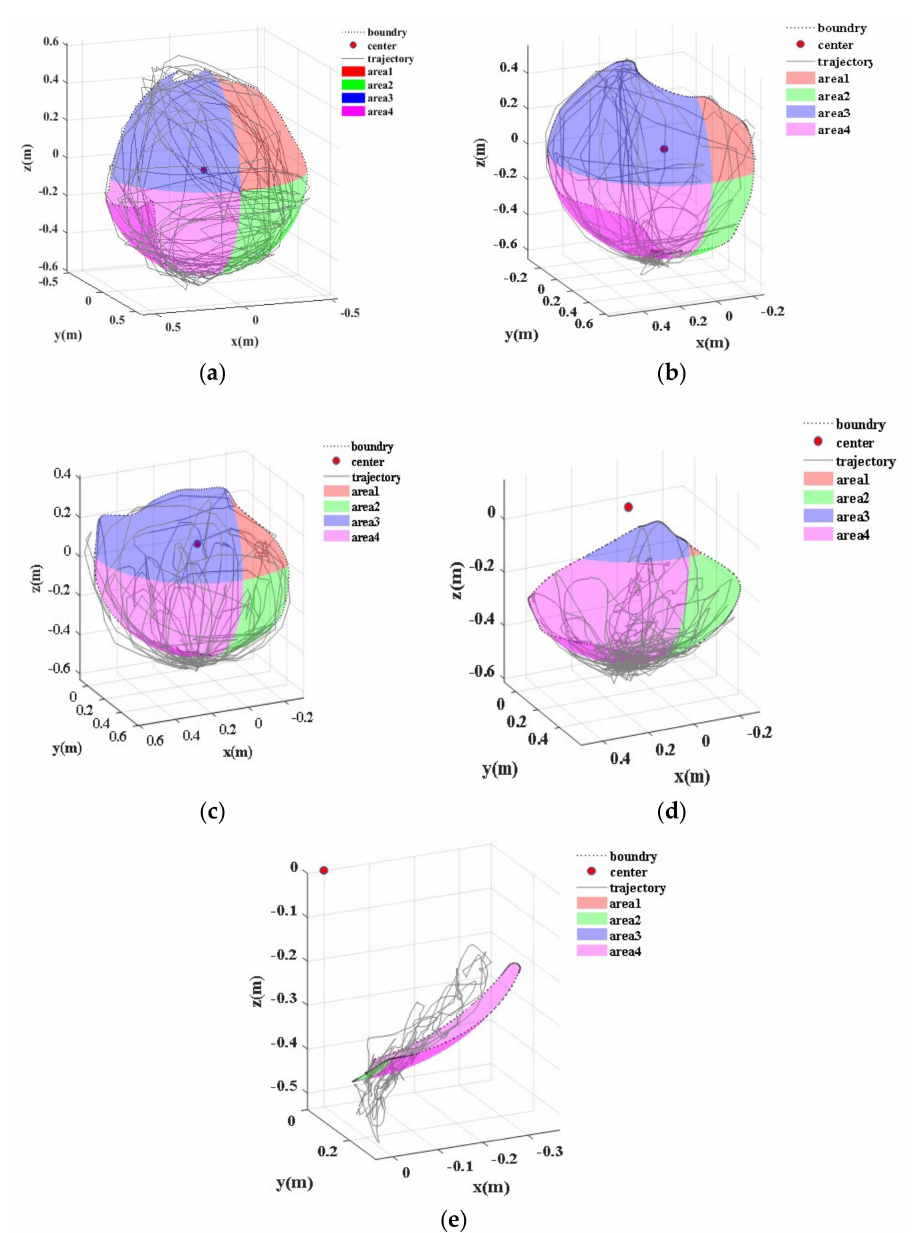
Figure 9. 3D reachable workspace of post-stroke patients: ( a ) patient 1, right hand, FMA score is 65; ( b ) patient 2, right hand, FMA score is 51; ( c ) patient 3, right hand, FMA score is 37; ( d ) patient 4, right hand, FMA score is 22; ( e ) patient 5, left hand, FMA score is